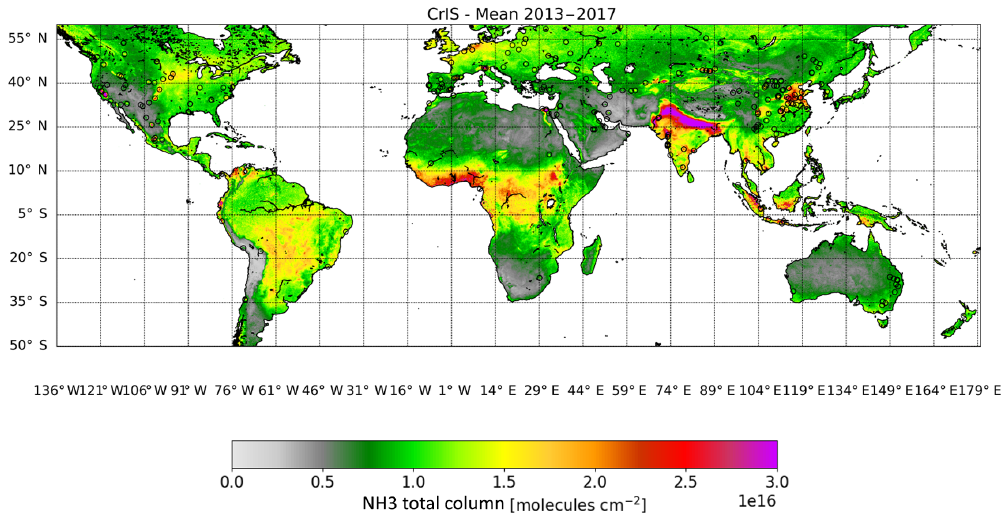
Figure 1. CrIS NH 3 5-year mean (2013–2017) total column (moleculescm − 2 ) distribution at 0.05 ◦ × 0.05 ◦ (long, lat) resolution, with the source locations of successful estimates shown by black circles centered around the source